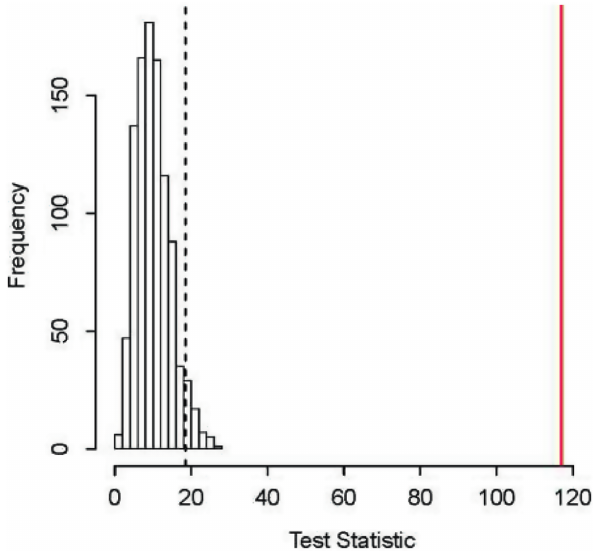
Figure 4: Unconditional randomization test using Kruskal-Wallis test